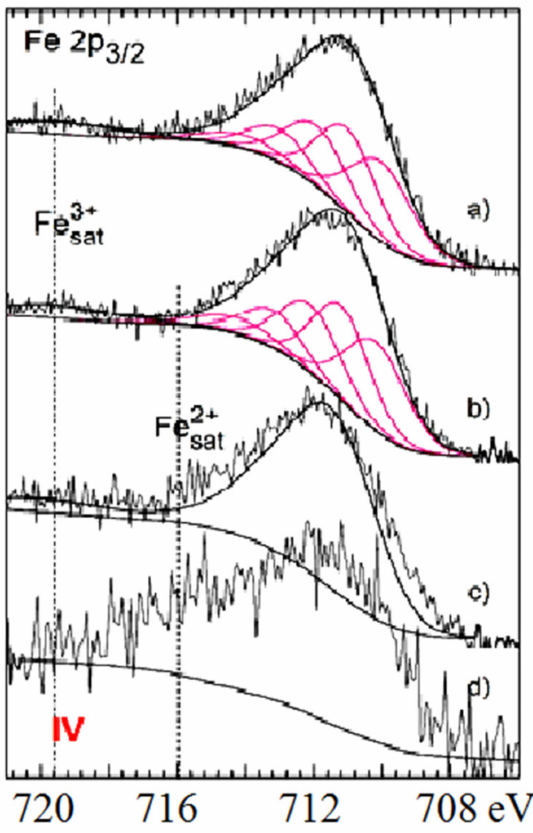
Figure 5. Fe 2p 3/2 core level spectra of ( a ) FeO(OH)-zeolite, ( b ) FeO(OH)-MnOx-zeolite, ( c ) FeO(OH)- zeolite powdered, and ( d ) natural